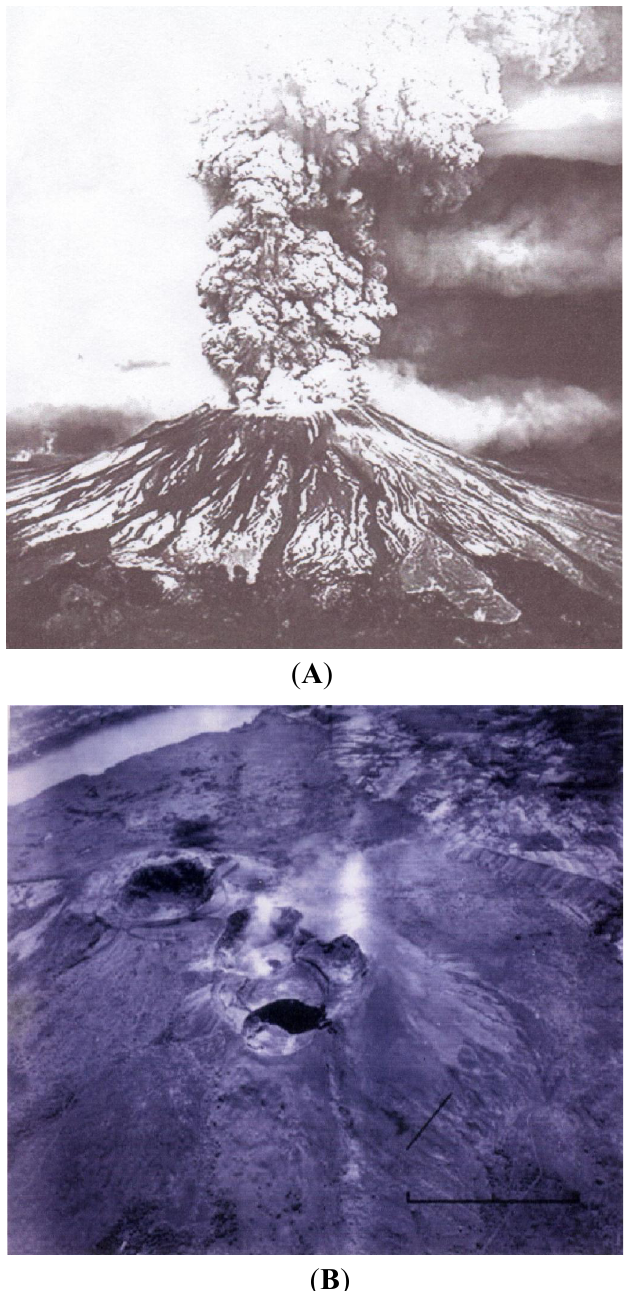
Figure 5. ( A ) 2 March 2010 Eruption of Masaya Caldera, 2N, 86.1W. 11 km